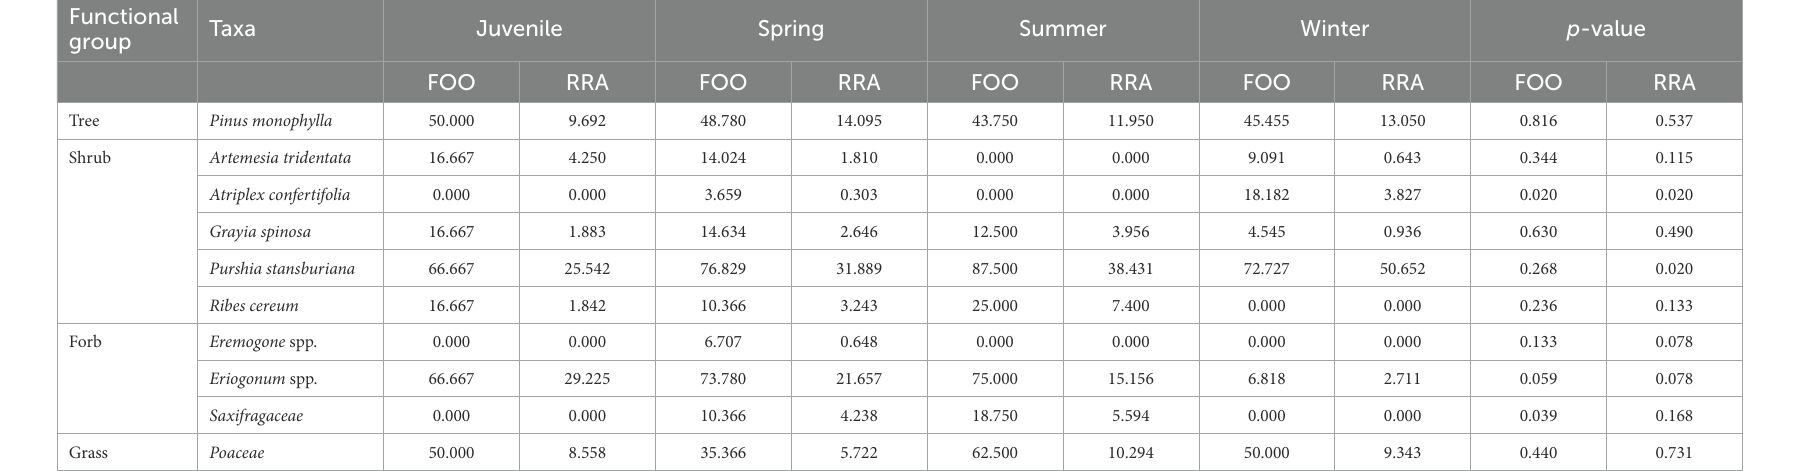
TABLE 6 Frequency of occurrence (FOO) and relative read abundance (RRA) of the top 12 unique plant taxa (based on total read counts) identified in the diets of desert bighorn sheep across seasons (i.e., Spring: March – May, Summer: June – August, Winter: November – February) and between juveniles and adults in spring months, at Lone Mountain, Nevada (2016–2018). Functional